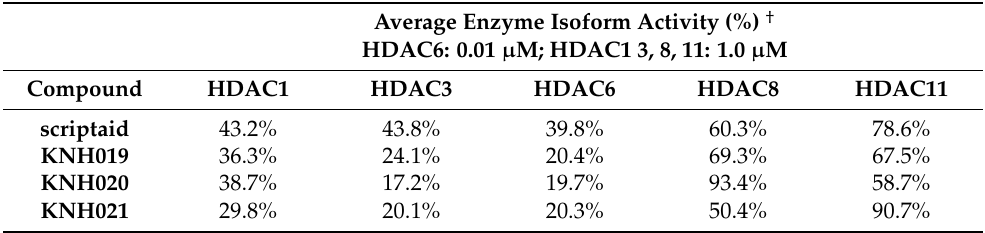
Table 3. HDAC activity (percentage of full enzyme activity) for 3-amido scriptaid analogues.